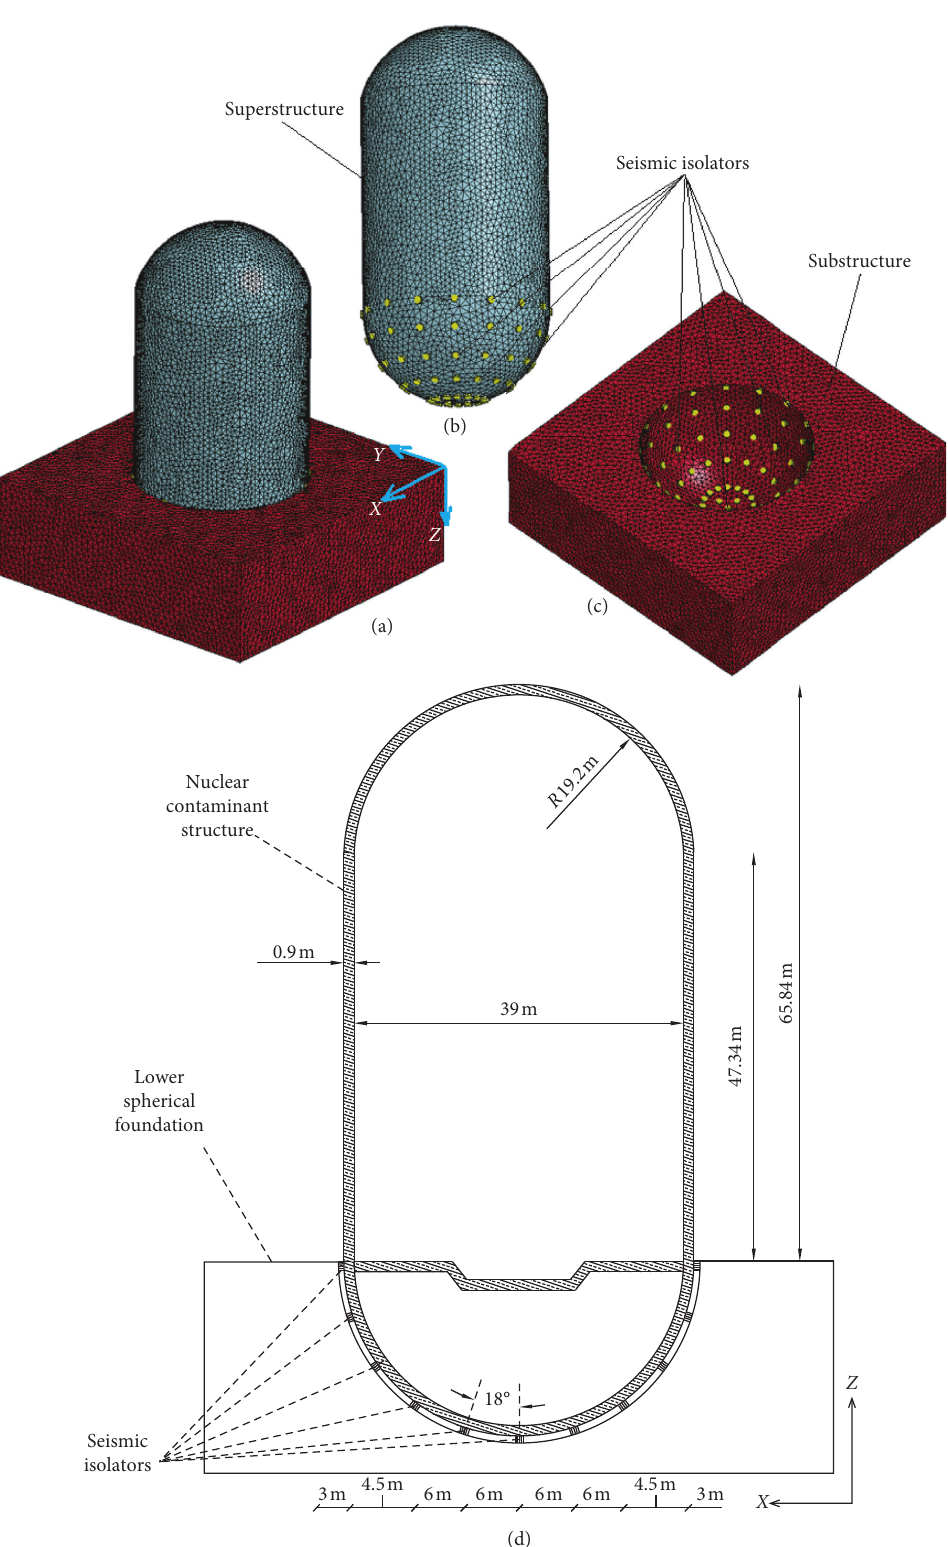
Figure 3: Overall view and illustration of the finite element model of the nuclear containment structure with the SSIS (a–c); the position of deployed seismic isolator and dimensions of SSIS-NC structure